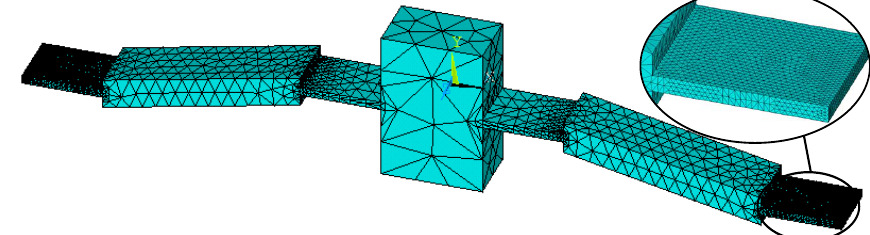
Figure 9. The finite element model for the classic fully-compliant bistable mechanism.